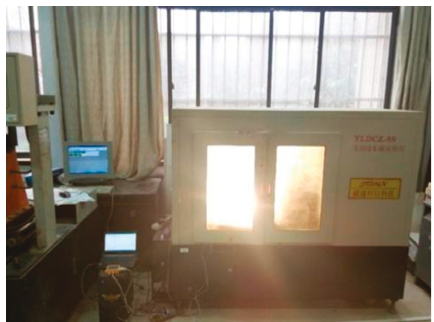
Figure 4: Illumination rutting test system.